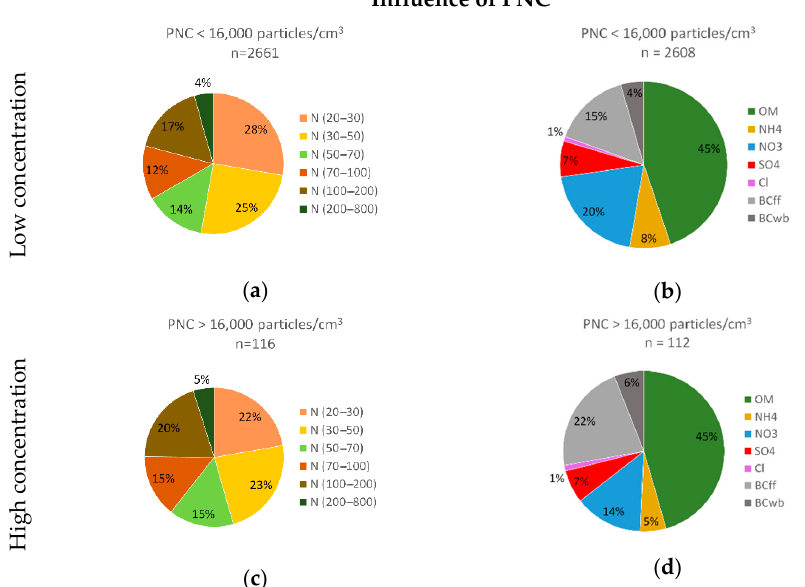
Figure 9. Particle size contribution ( a ) and chemical composition ( b ) for low PNC and particle size contribution ( c ) and chemical composition ( d ) for high PNC at the background